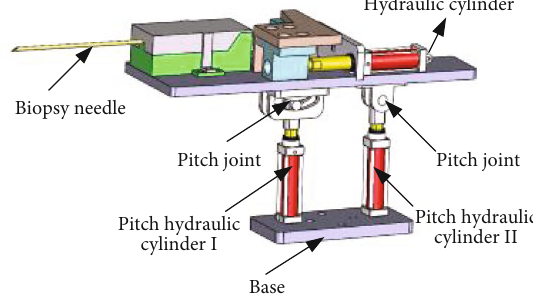
Figure 8: Link frames of breast intervening robot. Table 1: Denavit-Hartenberg parameters of the robotic